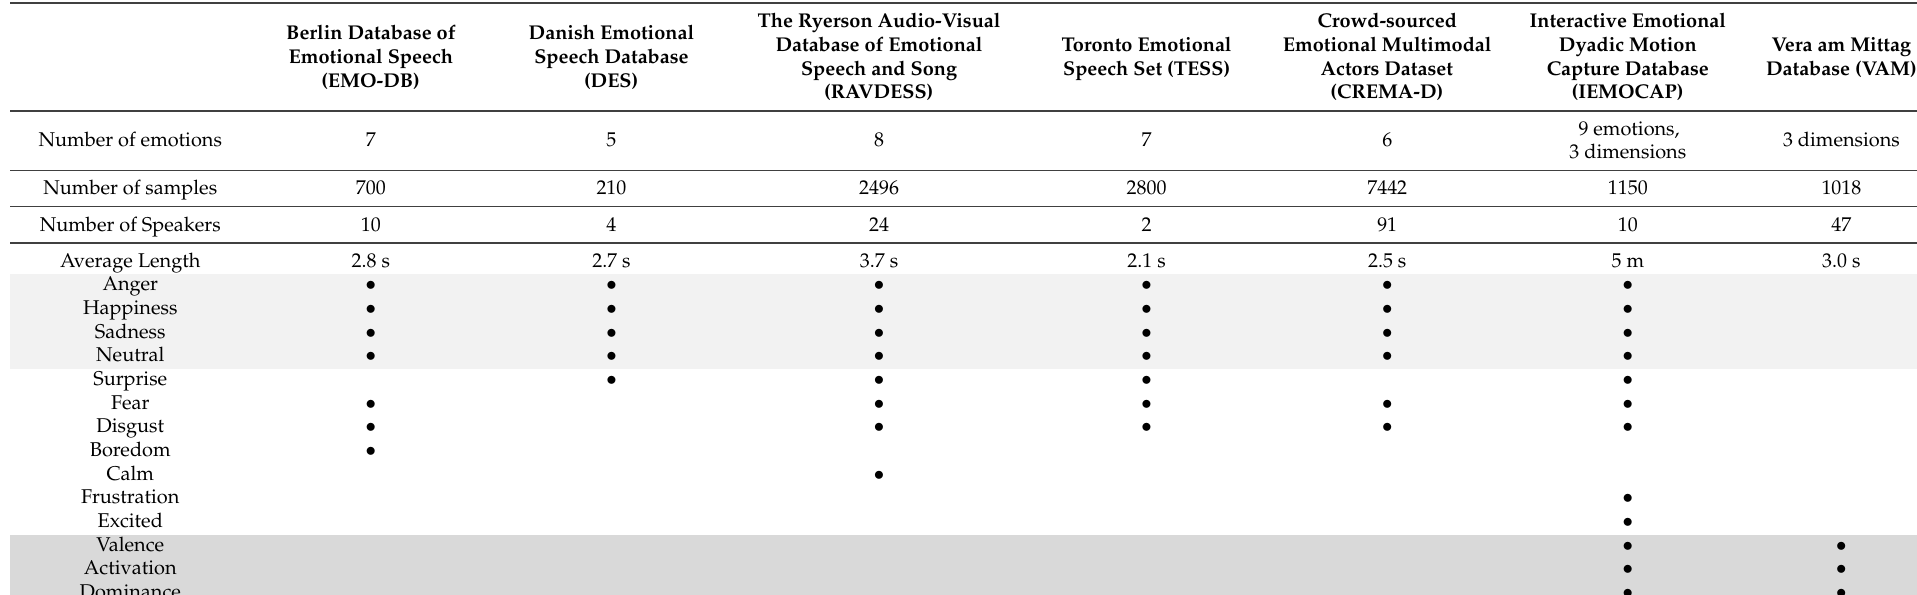
Table 2. Statistics of the reviewed databases and their types of emotion. Availability of an emotion in a database is represented with a black dot ( • ) in the corresponding cell. The light gray section in the table shows the emotions shared between all the databases, and the darker gray section at the end of the table shows the 3 dimensions of continuous dimensional emotion